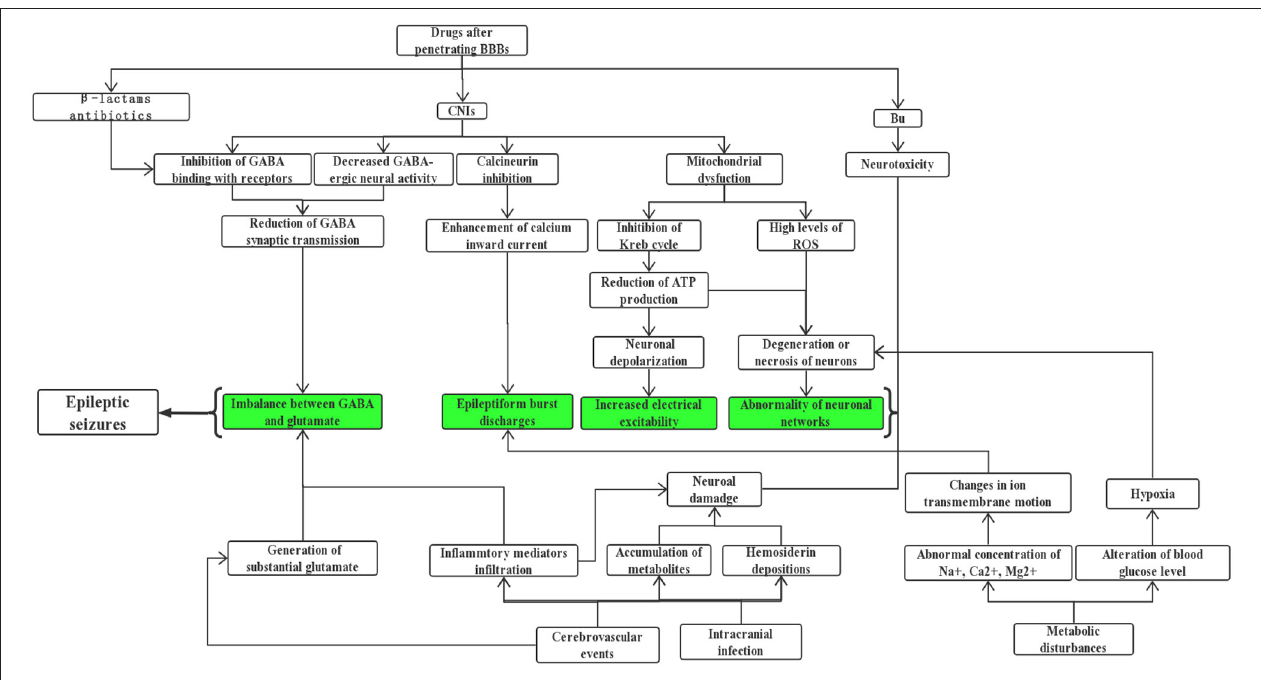
FIGURE 1 | The main mechanisms of seizures after